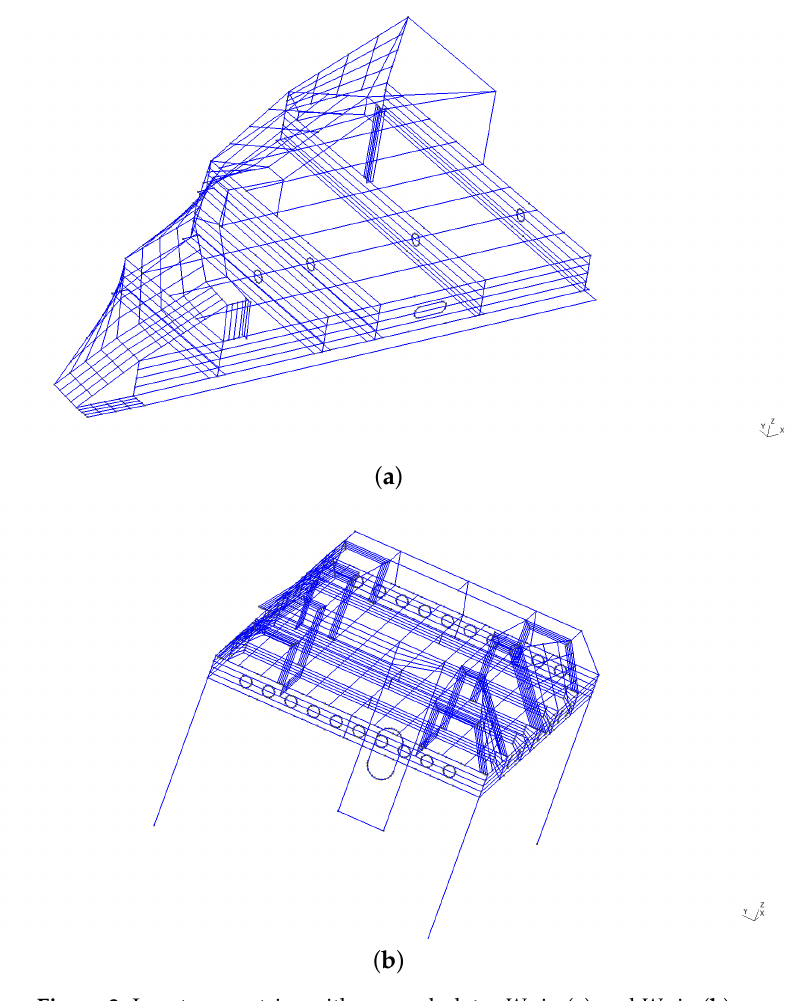
Figure 3. Input geometries with warped plates W 1 in ( a ) and W 2 in ( b ).